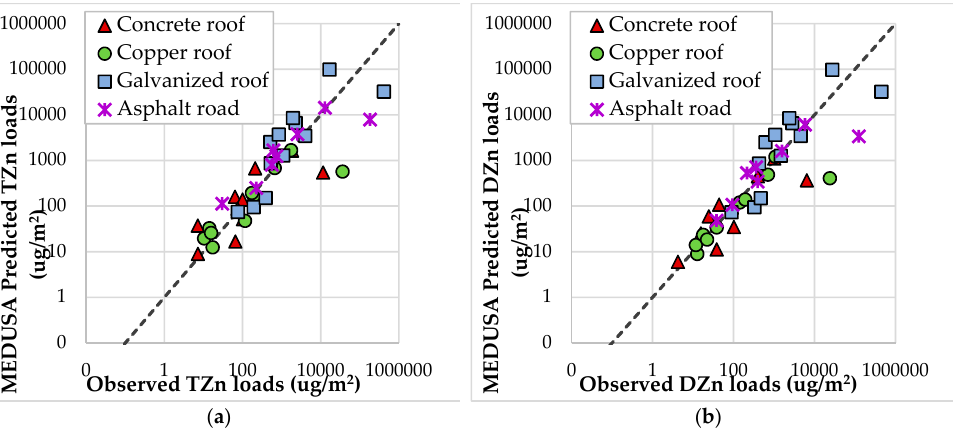
Figure 5. Predicted loads against observed loads for ( a ) total copper and ( b ) dissolved copper, for Okeover surfaces. Water 2020 , 12 , x FOR PEER REVIEW